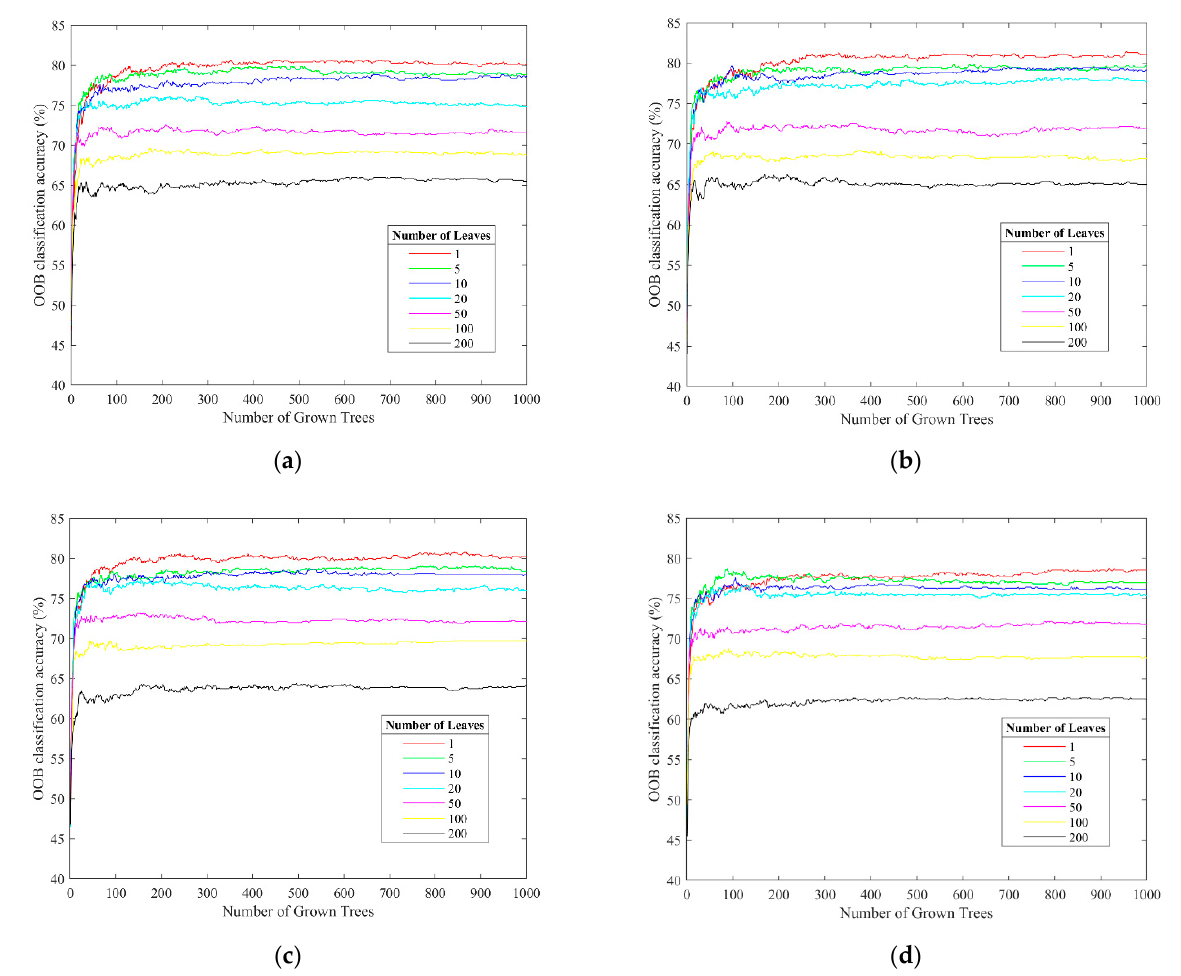
Figure 9. OOB classification accuracy for the four MS indicators with different numbers of trees and leaves: ( a ) Station; ( b ) Gid; ( c ) Wifimac; ( d ) Loginmac.